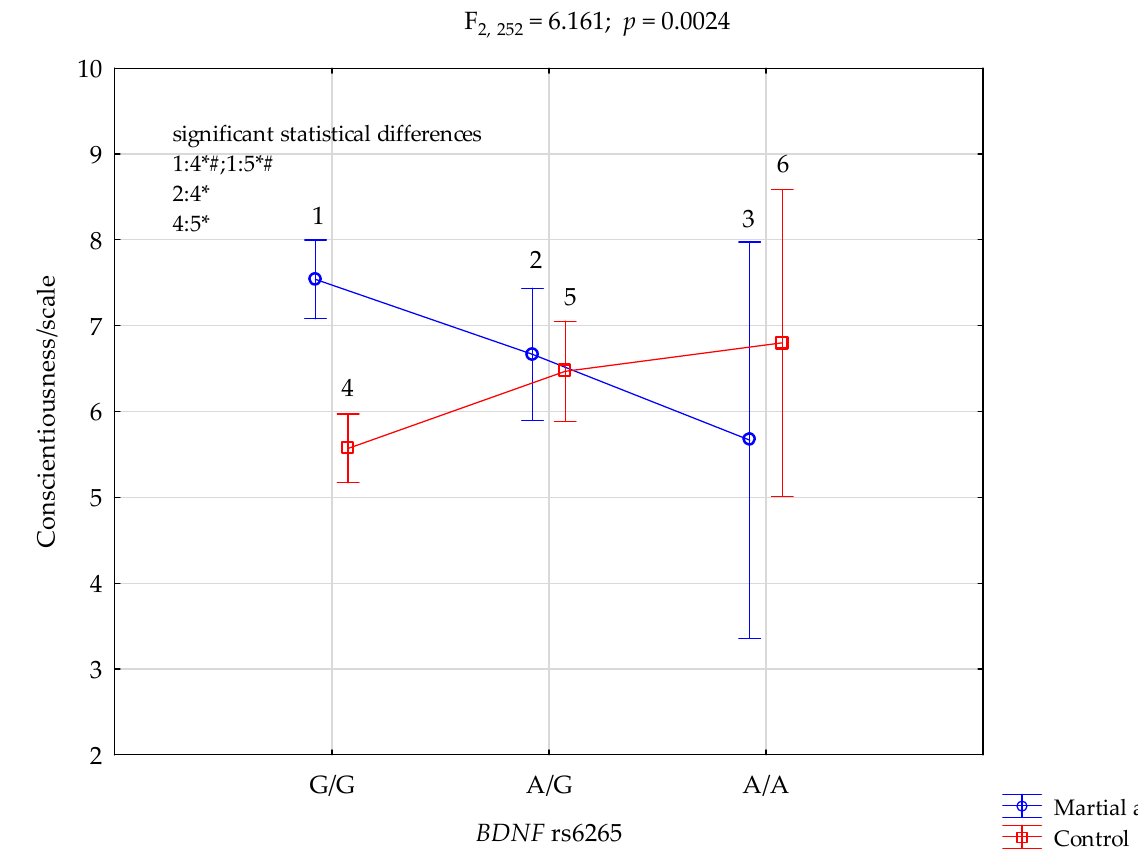
Figure 2. Interaction between martial arts/control and BDNF rs6265 and conscientiousness scale. # Bonferroni correction was used, and the p -value was reduced to 0.0083 ( p = 0.05/6 (number of sta- tistical tests conducted)). G/G and A/A—genotypes (homozygotes), A/G—genotype (heterozygote), G and A—alleles, 1—G/G, 2—A/G, 3—A/A, 4—G/G, 5—A/G, 6—A/A, BDNF —Brain-Derived Neurotropic Factor, F—F ratio score, * significant result p = 0.05, p — p